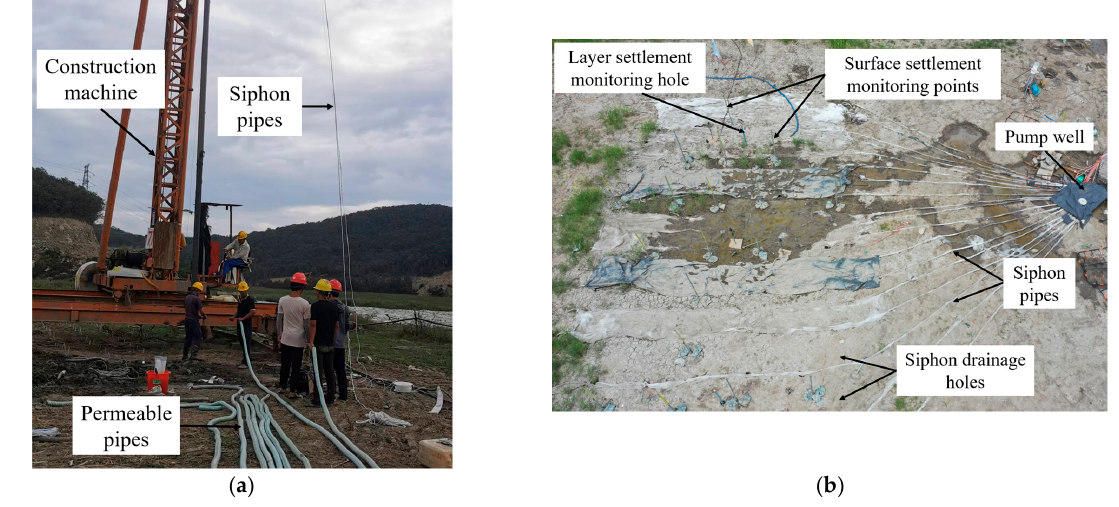
Figure 10. The fi gures of fi eld test. ( a ) Construction of siphon drainage holes. ( b ) Top view of fi eld Figure 10. The figures of field test. ( a ) Construction of siphon drainage holes. ( b ) Top view of test. field test.